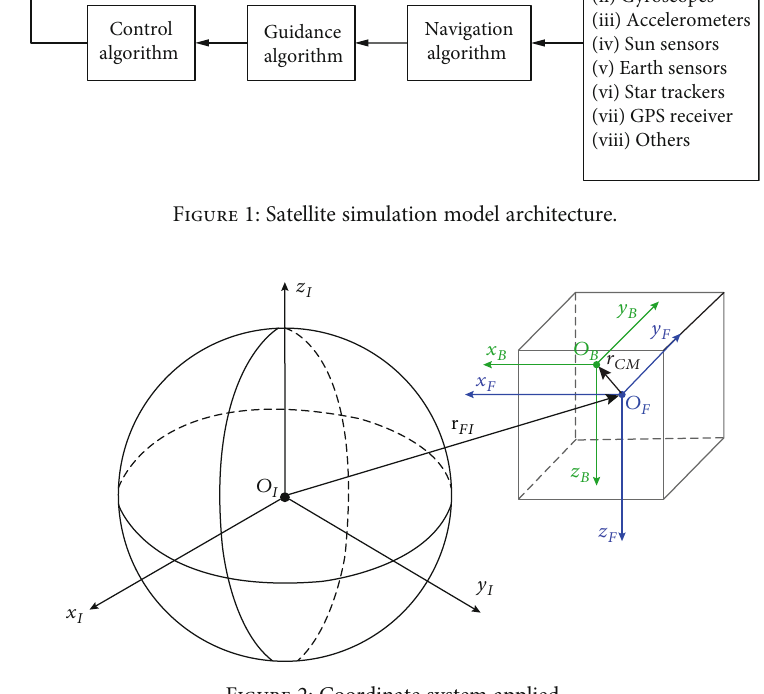
Figure 2: Coordinate system